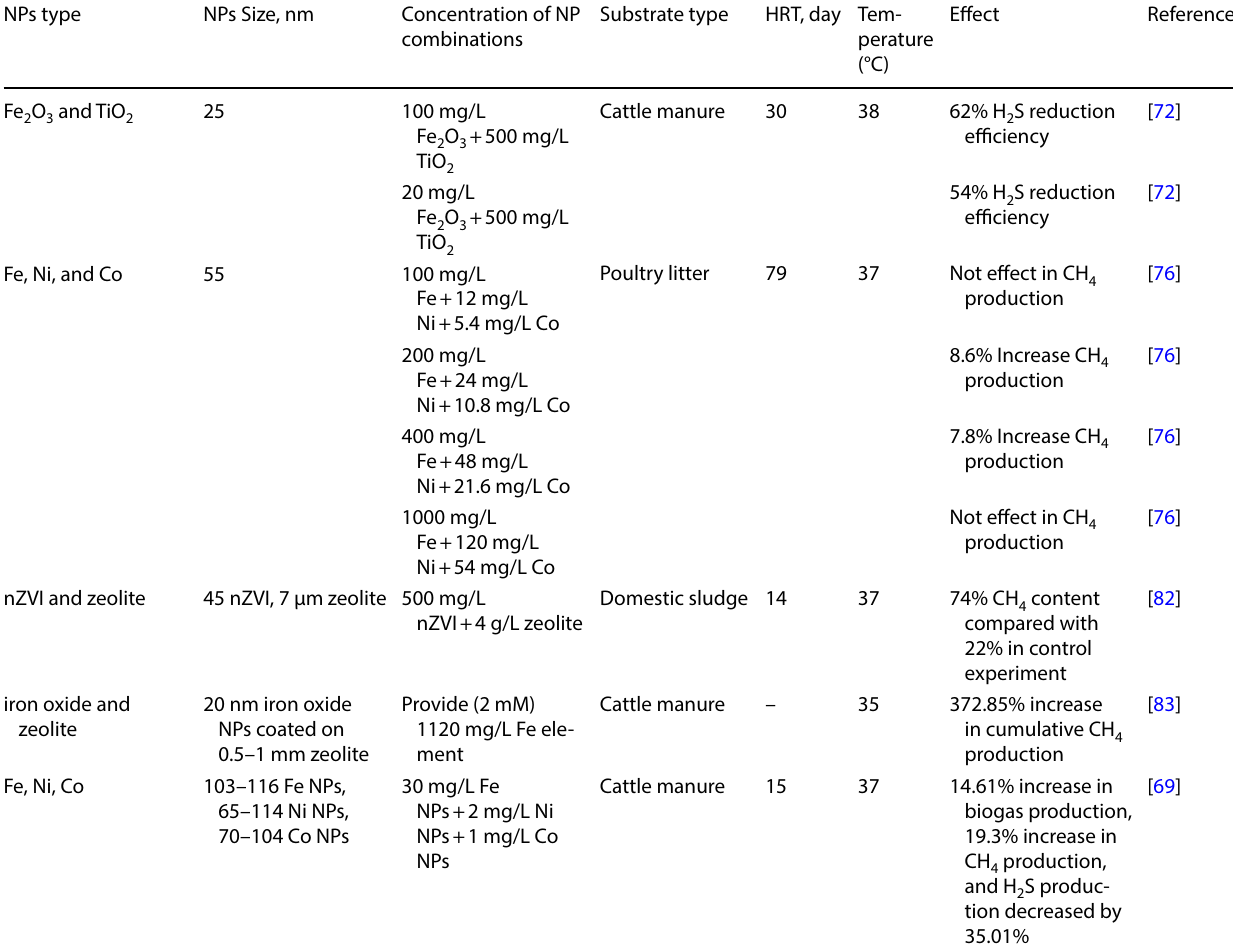
Table 4 Effects of nanoparticle combinations on the performance of biogas production process and effluent quality NPs